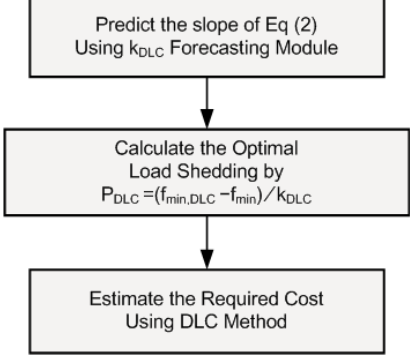
Figure 4. The operation of the DLC method.